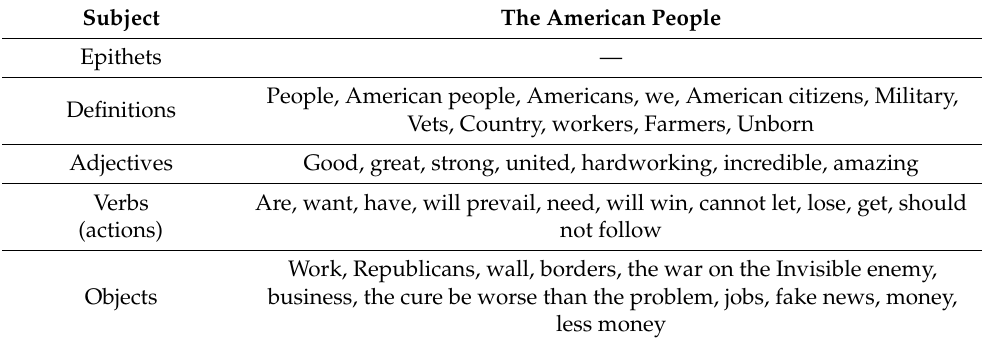
Table 10. The American